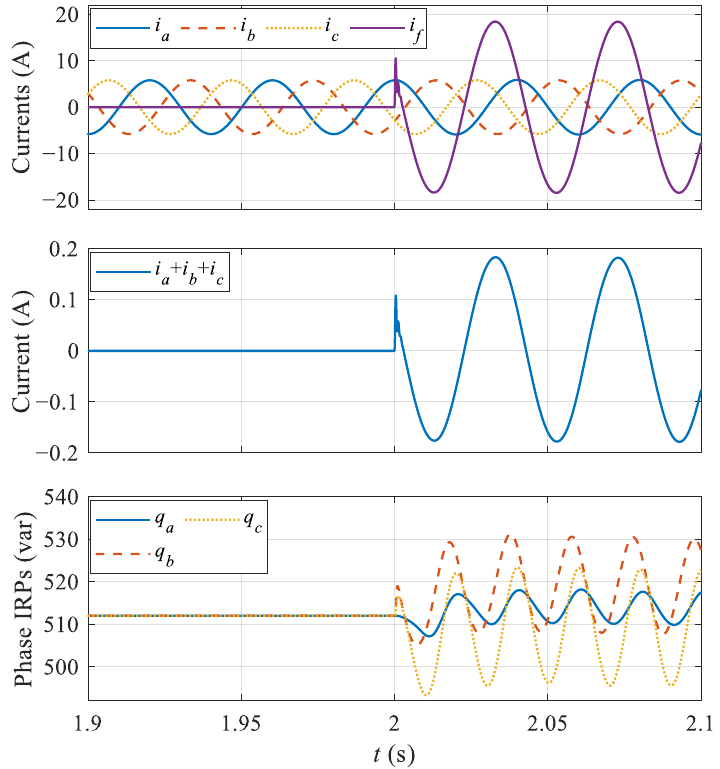
Figure 3. The phase currents and circulating current ( top ), the neutral current ( middle ) and the phase IRPs ( bottom ) before and after ITSC. Operating conditions: machine speed ω m = 300 r/min and load torque T L = 10 N · m. Fault severity: ∆ = 0.01, r f = 50 m Ω